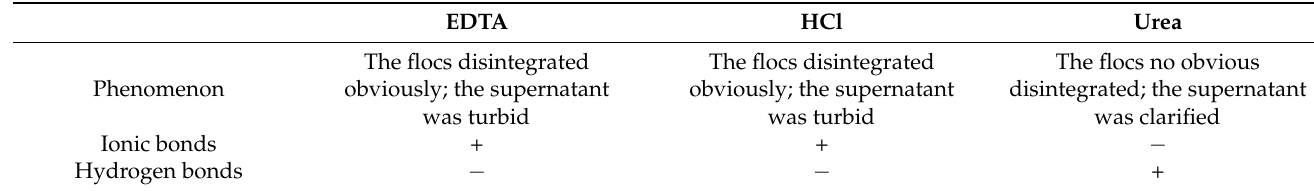
Table 2. Inspection of ionic and hydrogen